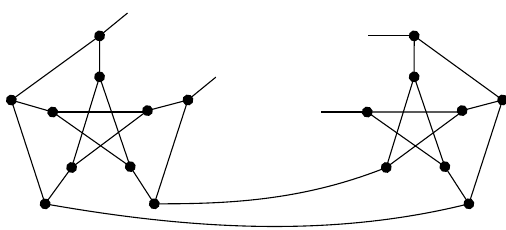
Fig. 2: One of the smallest Class 2 bricks.